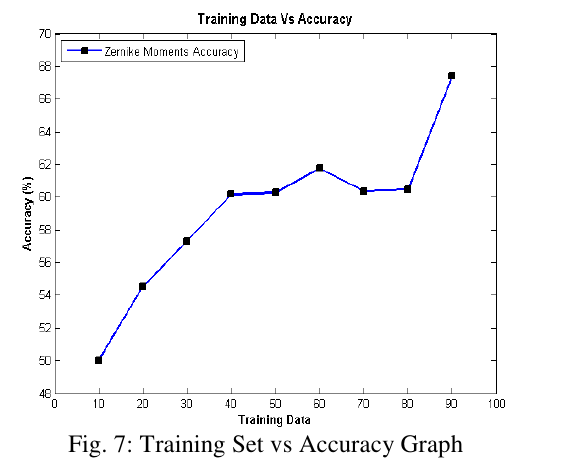
Fig. 7: Training Set vs Accuracy Graph